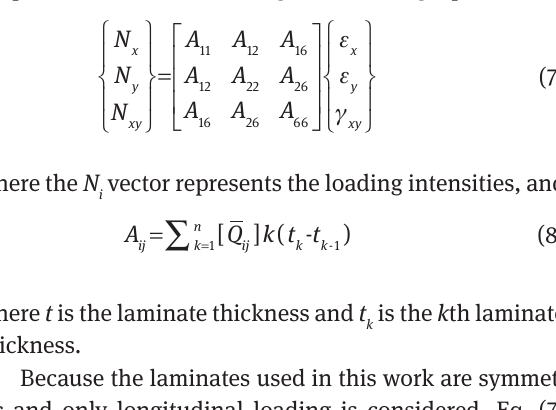
Figure 1 Stress vs. strain curves for [90